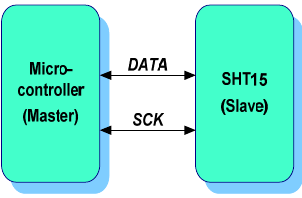
Figure 10. Communication interface between Waspmote and SHT15.